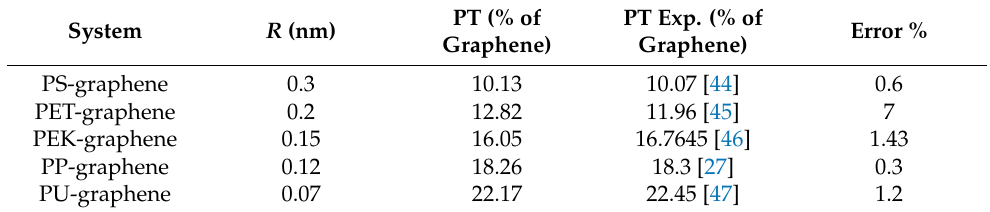
Table 3. Action radius ( R ), theoretical percolation threshold, experimental percolation threshold, and percentage error. All values are represented as a function of % of graphene nanoparticles. PT (% System R (nm)